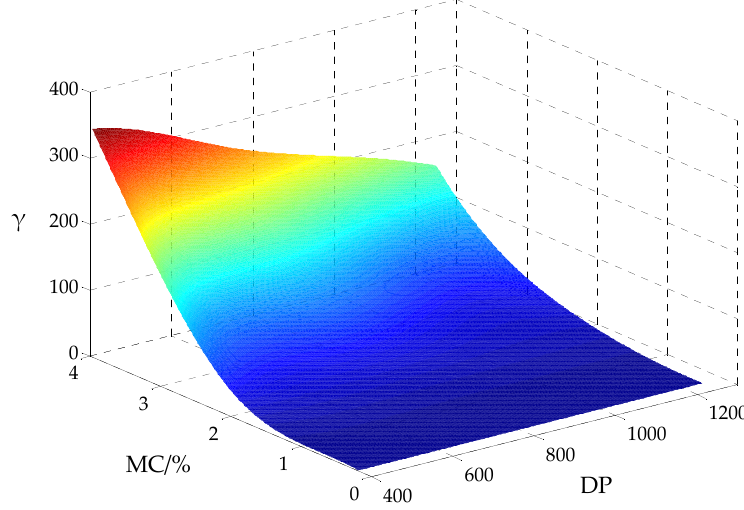
Figure 6. Fitting surface of moisture compensation factor.